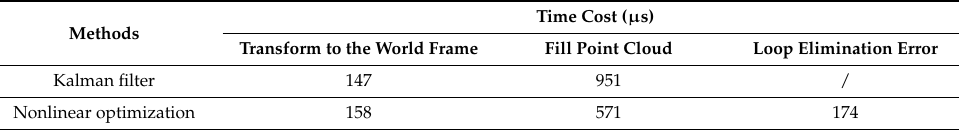
Table 5. Average time